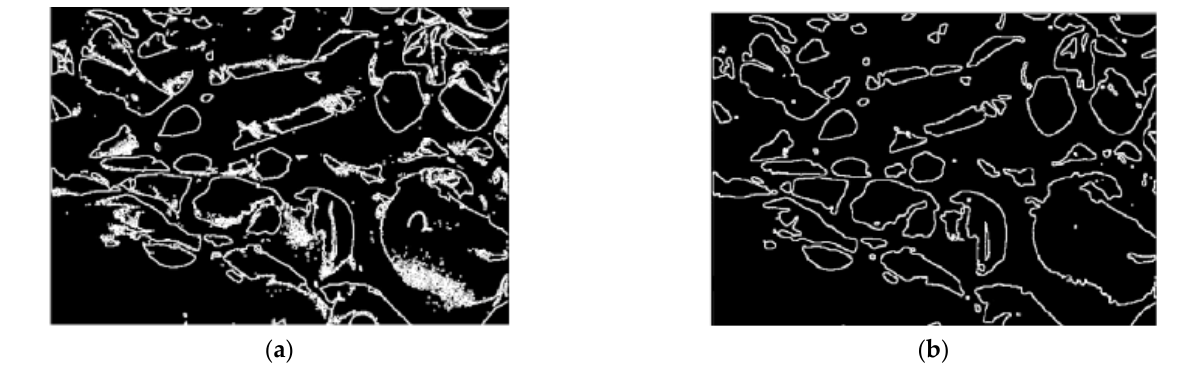
Figure 9. Edge extraction; ( a ) segmentation result without filter, ( b ) segmentation after median filter.